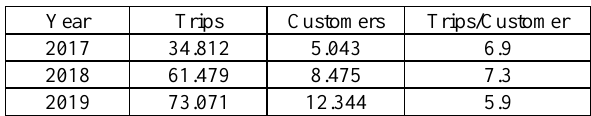
Table 1 . Ratio trips to customers in years 2017-2019